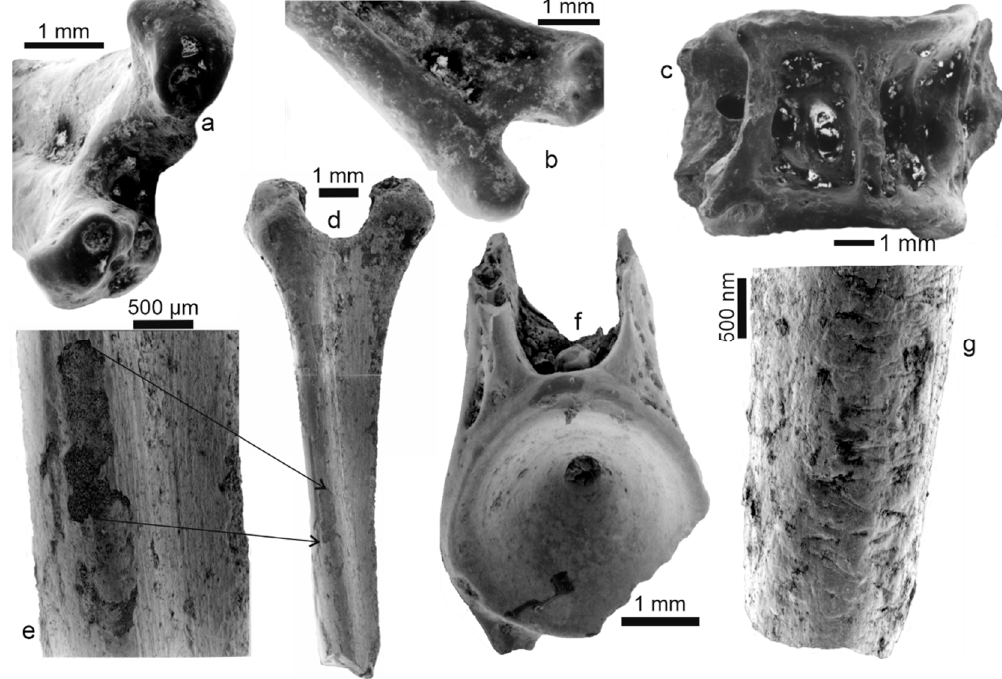
Figure 6. Fossil bones from Mwenirondo. ( a ) Fin spine articular head with sedimentary particles on articular zones despite the cleaning process (formic acid 5% for 1 min). ( b ) Posterior view of the same bone. ( c ) Lateral view of a vertebra with small sedimentary particles. ( d ) Spine bone displaying traces of digestion on the articular extremity (holes, polished surfaces) but also a light weathering, light desquamation, and dissolution of the surface. ( e ) Detail of Figure 6d, showing the rough surface of a spine bone with irregular eroded zones. ( f ) Vertebra centrum with a polished surface and tiny holes on the apophyses. ( g ) Spine bone ending with a transvers fracture and showing a rough surface with desquamation.